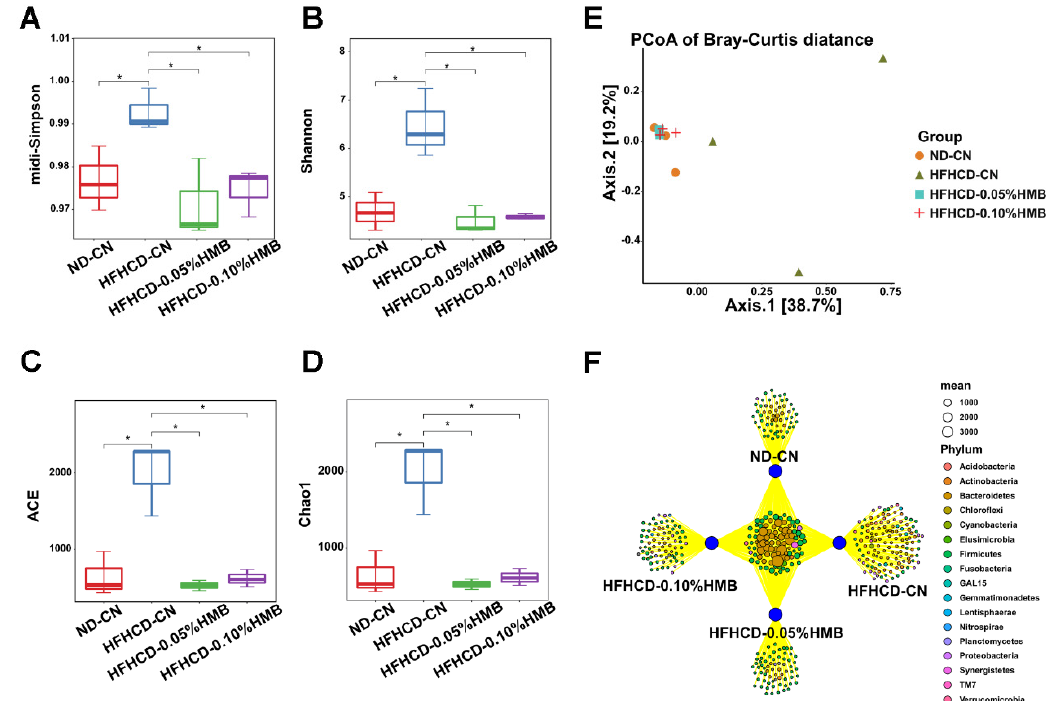
Figure 5. Effects of HMB on the richness and diversity of gut microflora in HFHCD–challenged layers. ( A ) Histogram for comparison of species diversity (midi-Simpson index). ( B ) Histogram for comparison of species diversity (Shannon index). ( C ) Histogram for comparison of species richness (ACE index). ( D ) Histogram for comparison of species richness (Chao1 index). ( E ) Principal coordinates analysis (PCoA). ( F ) Venn Diagram analysis. * p < 0.05.